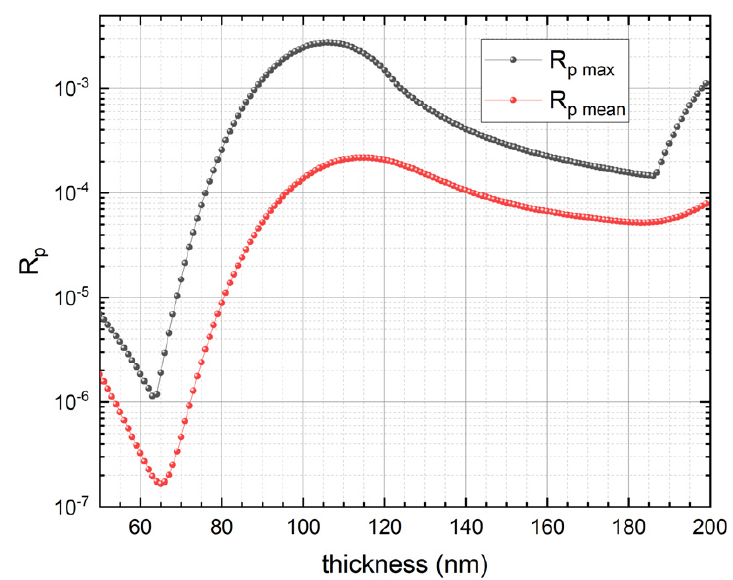
Figure 6. Maximum and mean values evaluated in the wavelength interval 400—850 nm of the p-polarization reflectance as a function of SiN x thickness for PQEDs mounted in trap configuration with an angle of 15° between the diodes.